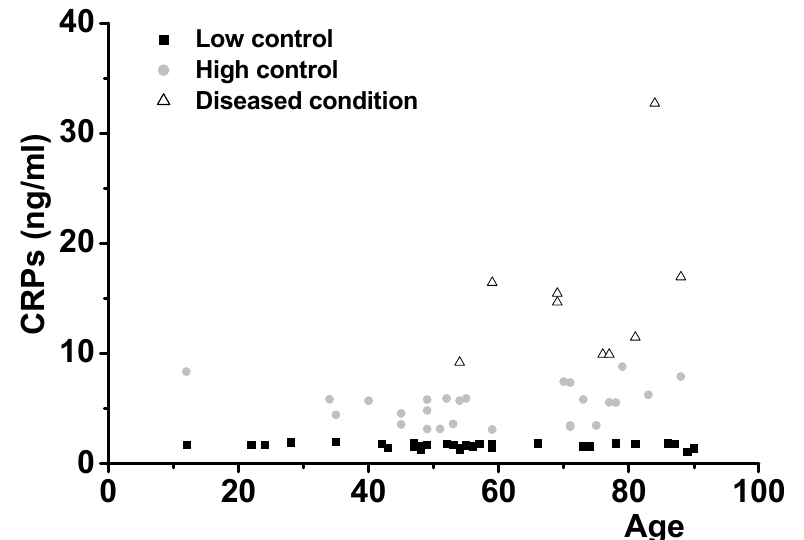
Figure 3. C-reactive proteins (CRPs) levels of low controls, high controls, and diseased conditions were tested. Averages and SD were 1.67 ± 0.21 for the low-level control group (31 cases), 5.34 ± 1.70 for the high-level control group (26 cases), and 15.20 ± 7.21 for the 9 diseased cases. One-way ANOVA was carried out to test the significance of the data: p < 0.01 between low controls, high controls, and diseased conditions and p < 0.01 between high controls and diseased conditions.